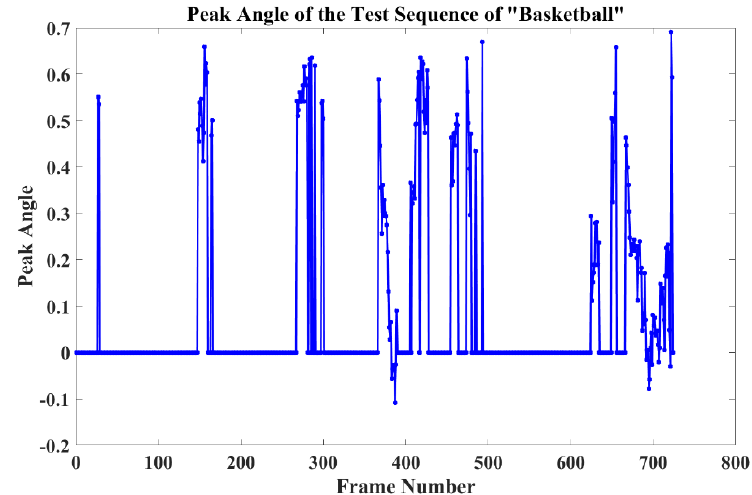
Figure 6. Object centre switching strategy.